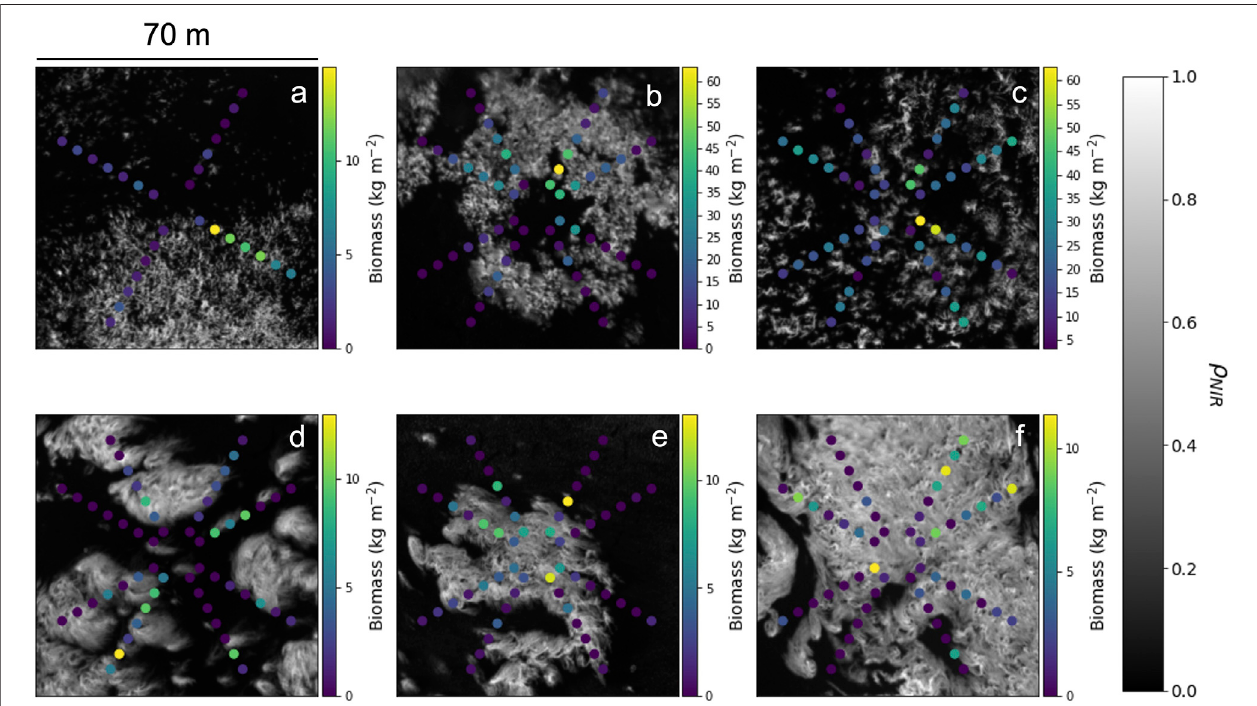
FIGURE4| MicaSense RedEdge-M near-infrared re fl ectance ( ρ NIR ) for each dive surveysite overlayed with thelocations for themidpointofeach transectinterval withthe color ofthe dot corresponding tothe measured in situ canopy biomass. (A) Noyo Harbor (NH), (B) Portuguese Beach (PB), (C) Point Piños(PP), (D) Otter Cove (OC), (E) San Carlos Beach (SCB), (F) Hopkins Marine Station (HMS).